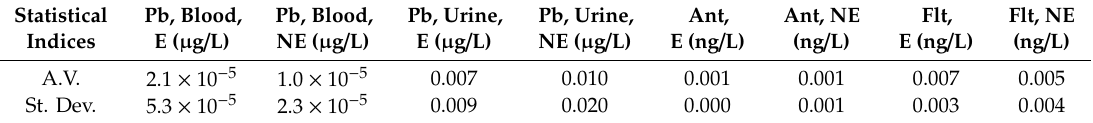
Table 9. Contaminant concentrations due to the air route only. E = exposed, NE = non exposed. Average value (A.V.) and standard deviations (St. Dev.). Pb = Lead, Ant = Anthracene, Flt = Fluoranthene.